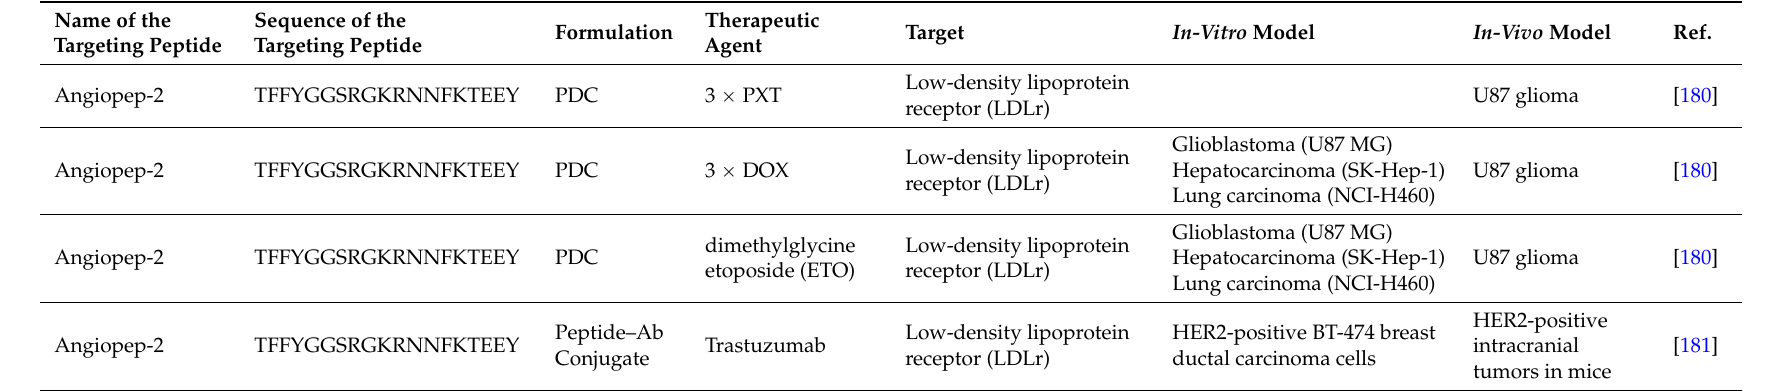
Table 5. Angiopep-2 cytotoxic